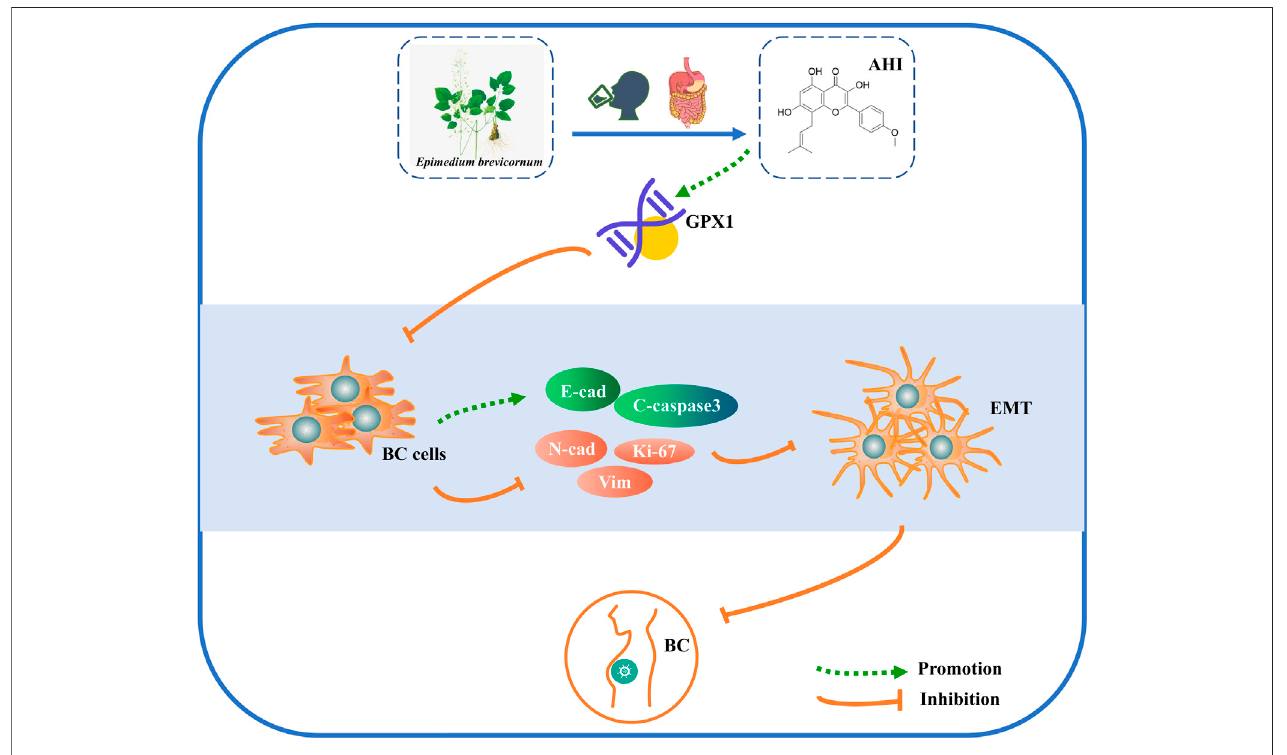
FIGURE 8 | Schematic diagram of the mechanism possibly involved in AHI-mediated